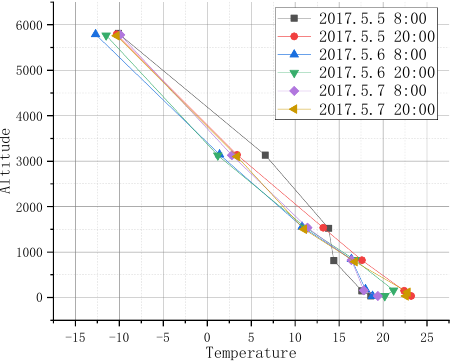
Figure 7. Concentration ratio of PM 2.5 to PM 10 Figure 9. Aerosol subtype during the dust pollution When pollutants invade the clean atmosphere, inversion is Through the continuous observation of the lidar placed in likely to occur. Inversion leads to difficult diffusion of huainan area, the formation process of pollutants on May 6 and pollutants in the vertical direction, which further aggravates the pollution weather. Figure 8 shows the vertical temperature profile obtained by radiosonde at the weather station nearest to the location of ground-based lidar when dust occurs. The results show that when the dust is transmitted to the Huainan area, the inversion phenomenon occurs on May 6 and May 7, and the inversion layer is lower. Since the dust weather lasts for a short time, the effect of inversion temperature is small.